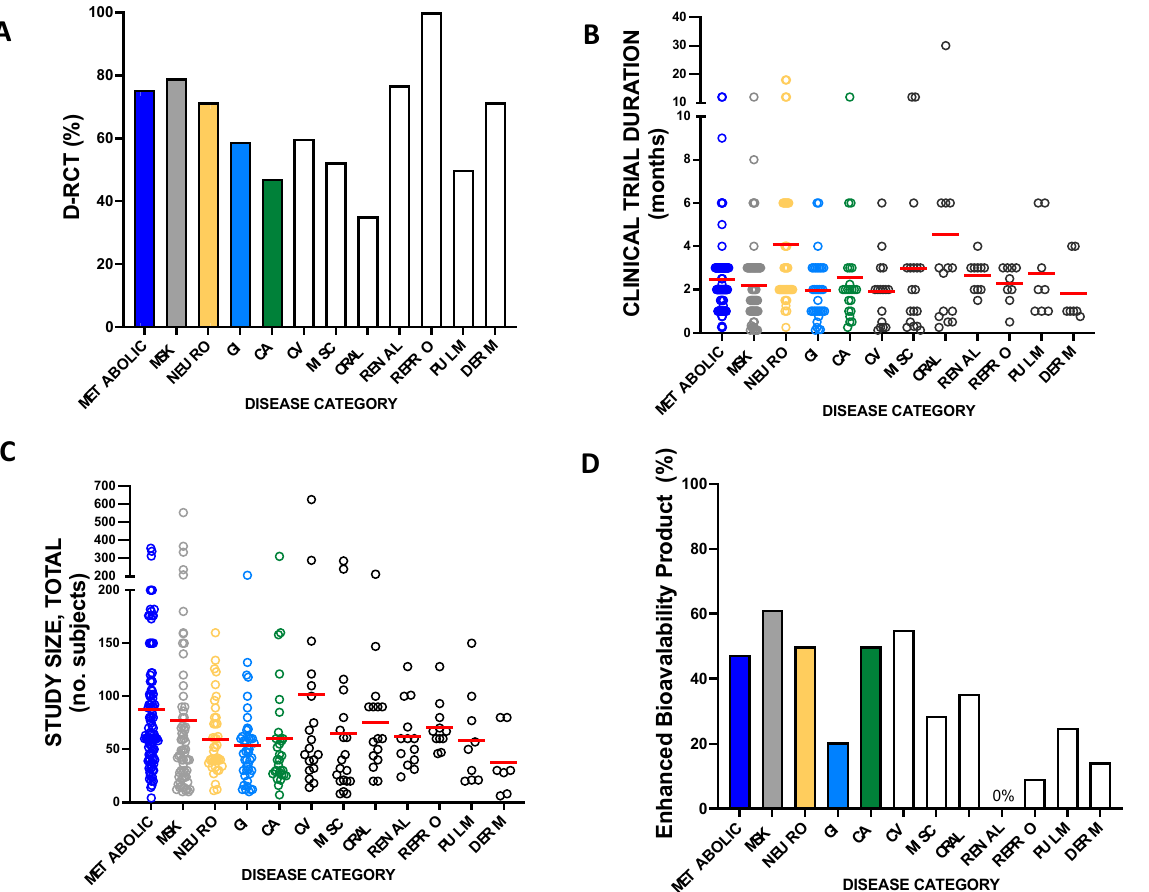
Figure 5. Curcumin clinical trial design elements by disease category. ( A ) Prevalence of citations reporting double-blind, randomized, placebo-controlled (D-RCT) trial results. ( B ) Curcumin clinical trial duration or ( C ) size, noting individual citations (open circles) and averages (red line). ( D ) Prevalence of citations reporting enhanced bioavailability curcuminoid product treatment effects.